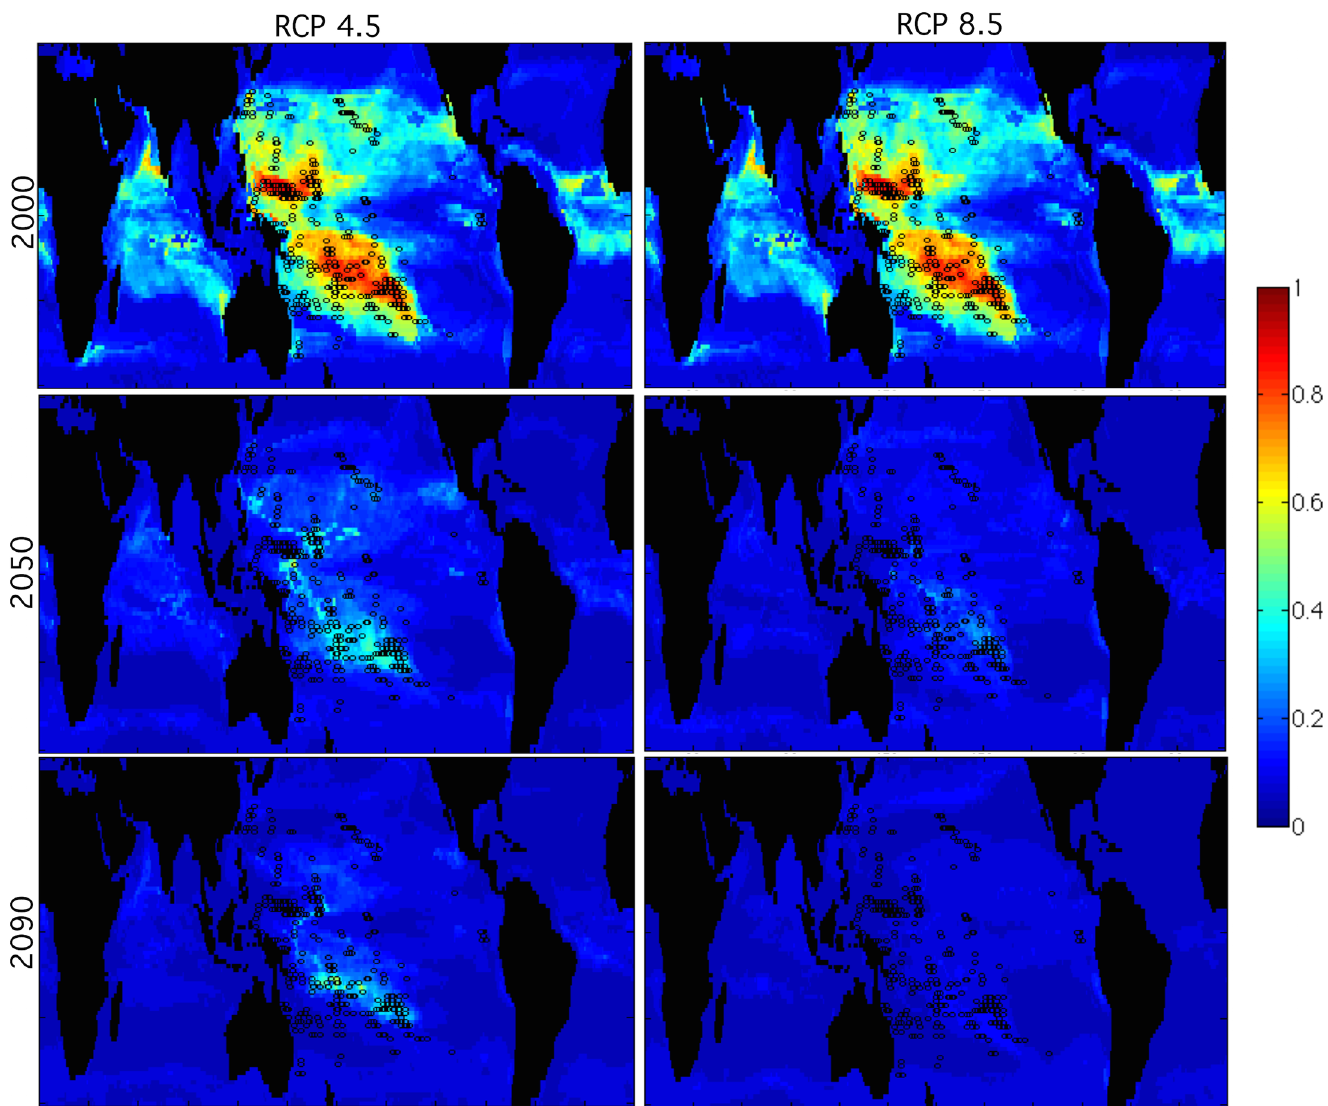
Fig 3. Maps Showing Suitable Habitat for All Remote Pacific Coral Reefs in Future Climate Projections. Maps of suitable habitat for all remote Pacific reefs in RCP4.5 (left column) and RCP8.5 (right column), shown for years 2000 (top), 2050 (middle), and 2090 (bottom). The color scale indicates the level of habitat suitability from marginal (blue) to highly suitable (yellow/red). Landmasses are shown in black. Coral reef locations used in this calculation are mapped as black circles.